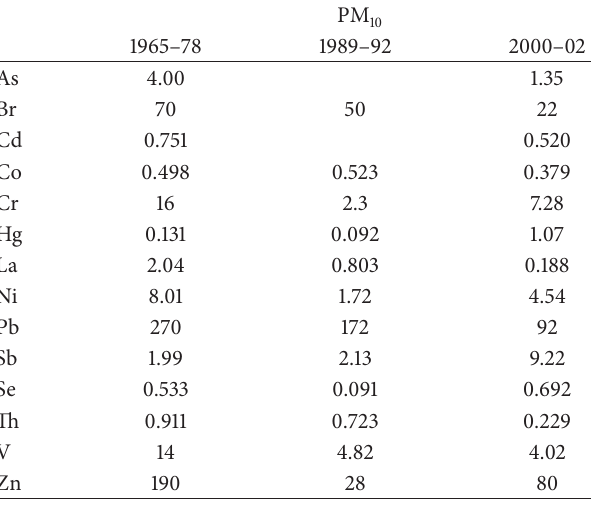
Table7:Levels(ng m − 3 )ofselectedelementsinvestigatedalongfour decades in downtown Rome.